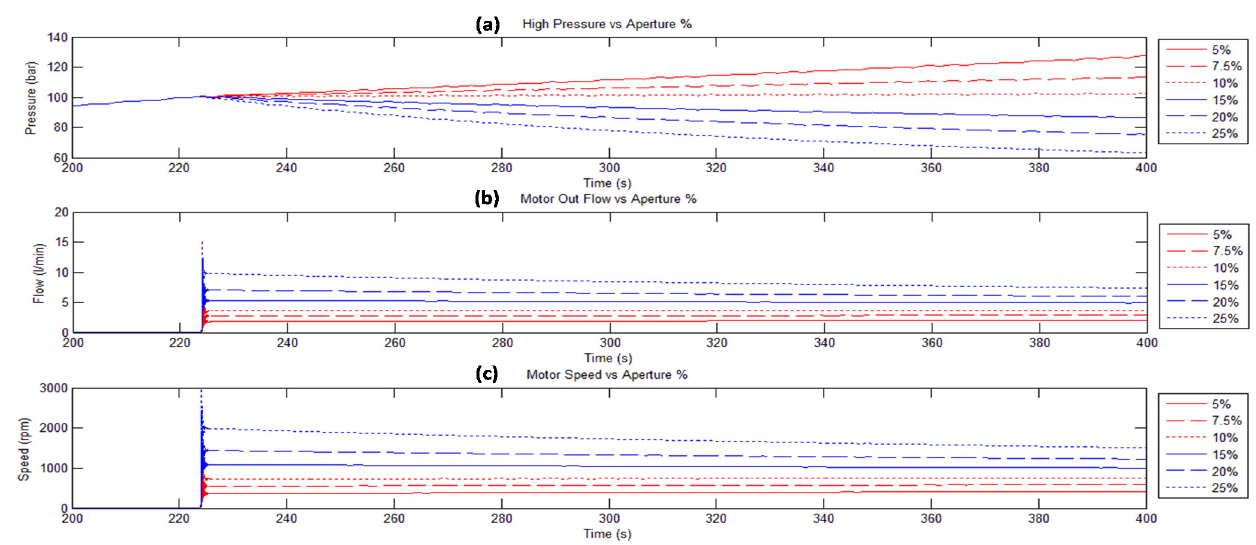
Figure 18. HP accumulator pressure Evolution in bar ( a ). Hydraulic Motor Flow Evolution in L/min ( b ). Hydraulic Motor Speed in rpm ( c ). Comparison between different control valve apertures using same activated hydraulic cylinders (HC3.1 and HC3.4). Config